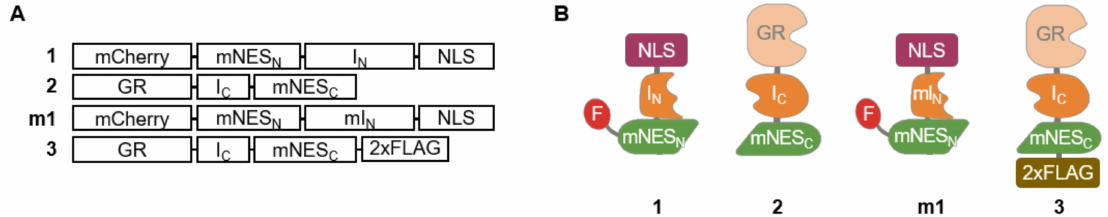
Figure 1. Fusion proteins used in this study. ( A ) Domain architecture of the DNA constructs of the fusion proteins containing N- or C-intein fragments; ( B ) a schematic illustration of fusion proteins 1 , 2 , m1 , and 3